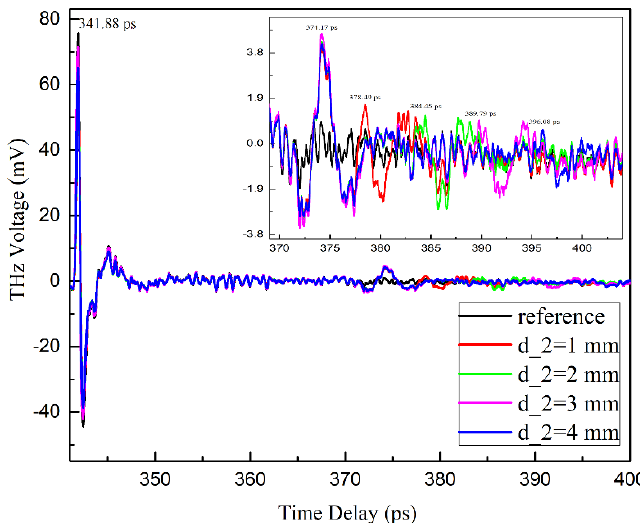
Figure 2. THz time ‐ domain spectra of the reference and hollowing deterioration samples. Figure 2. THz time-domain spectra of the reference and hollowing deterioration